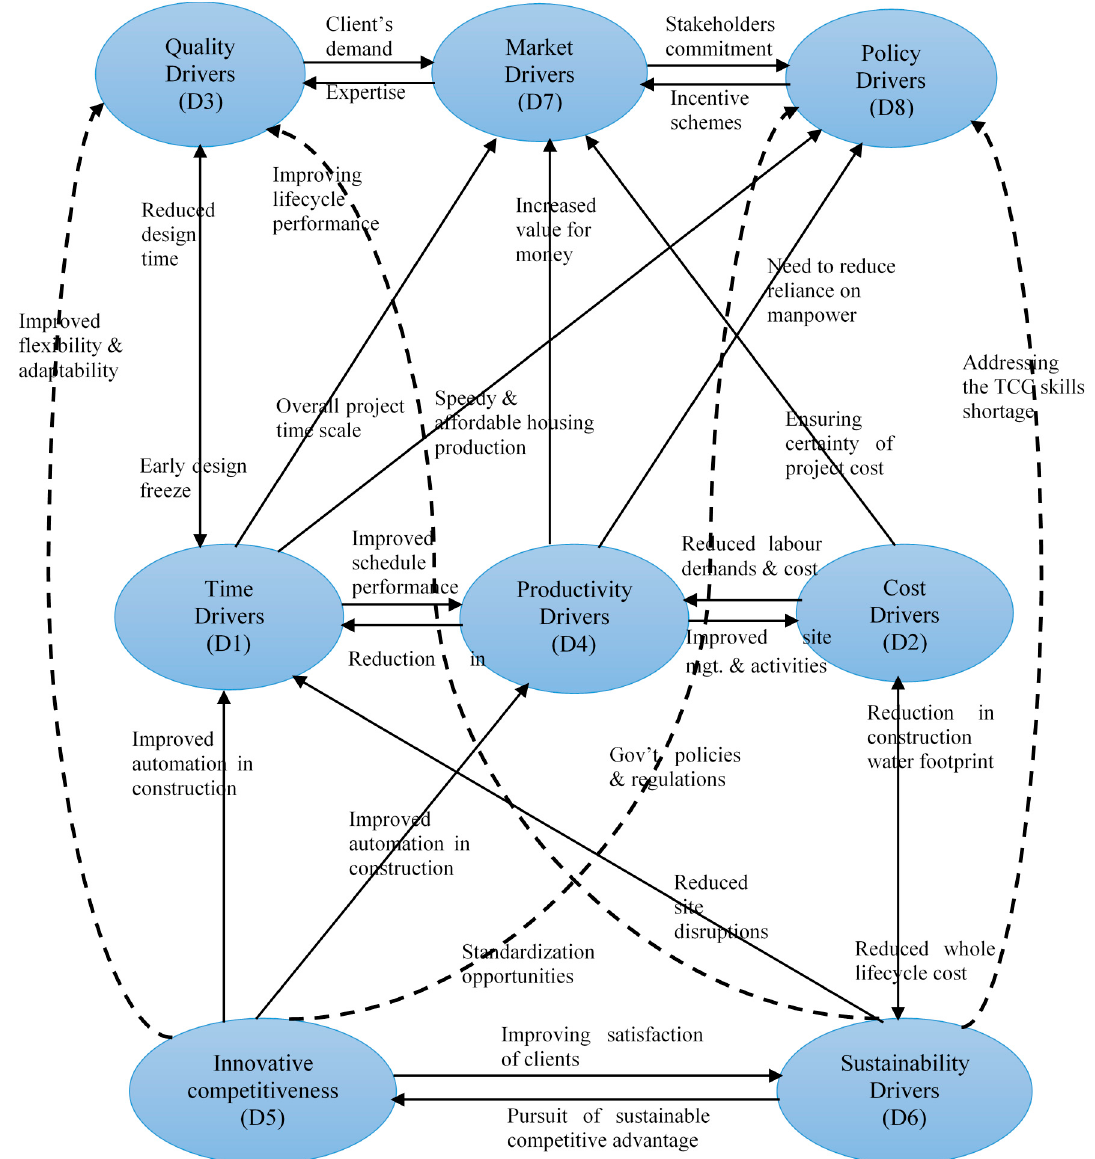
Figure 7. TISM model of the drivers of offsite construction (OSC).